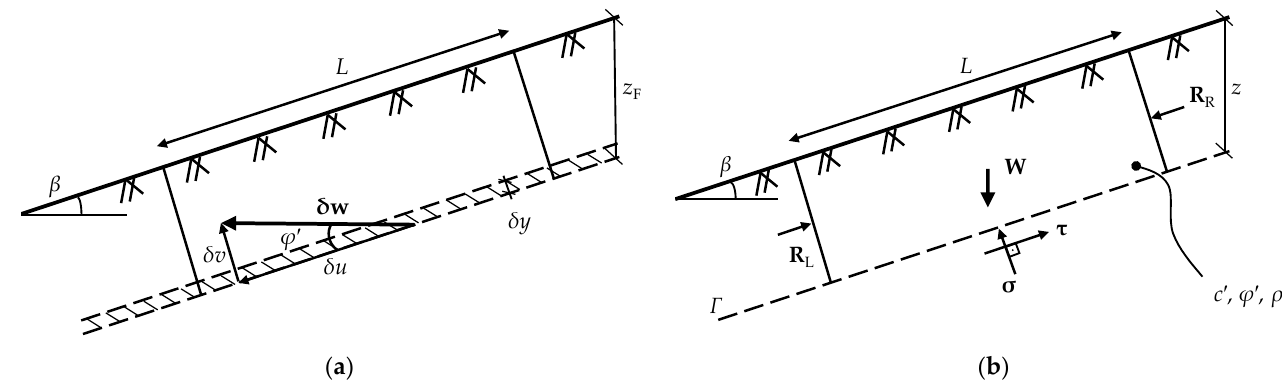
Figure 1. Section of the geometry of the unsaturated infinite natural slope considered. ( a ) Translational block of the failure mechanism; ( b ) Static equilibrium diagram.